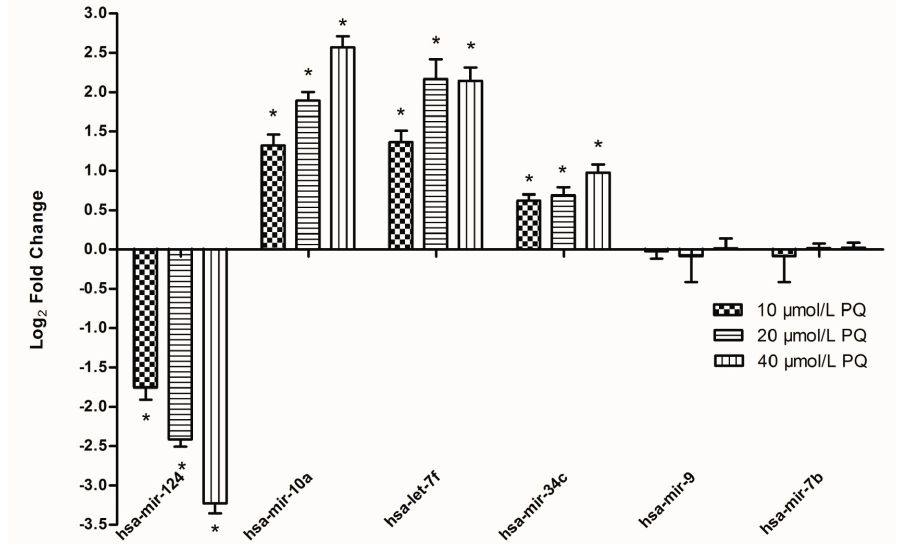
Figure 6. PQ-induced miRNA expression alterations. The selected miRNAs include three upregulated miRNAs, one downregulated miRNA and two unaffected miRNAs. hNPCs were treated with 0, 10, 20, or 40 μ mol/L PQ for 24 h and miRNA were isolated for real-time RT-PCR analysis. Data represent means ± SE with each analysis performed in triplicate. All values showed in the histograms represented as log 2 fold change compared to the control group average of 0. * Indicate statistically significantly higher than that in the